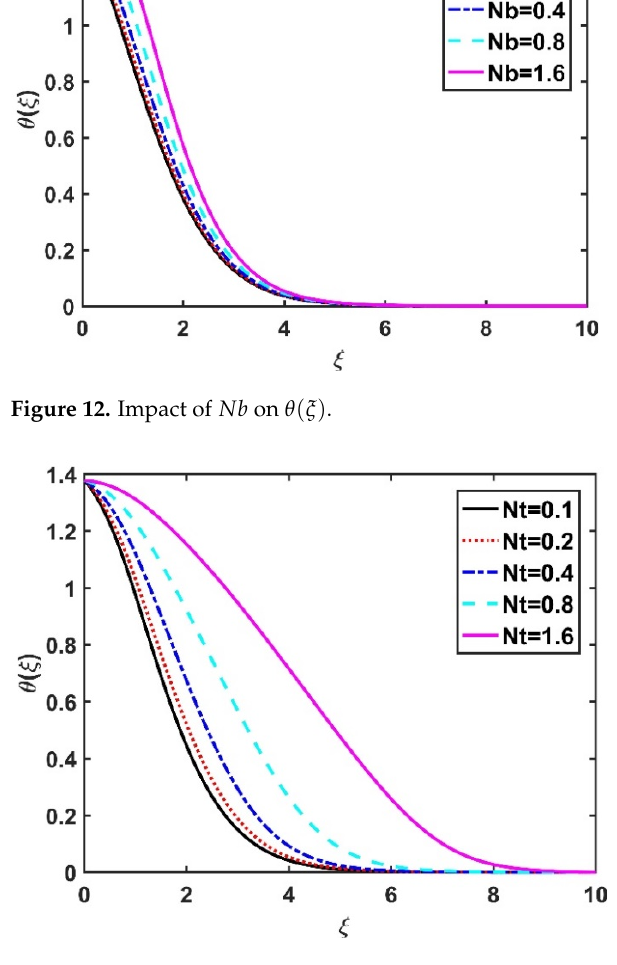
Figure 14. Impact of 𝑅𝑒 on 𝜃(cid:4666)𝜉(cid:4667) . Figure 15. Impact of 𝛼 (cid:2870) on 𝜃(cid:4666)𝜉(cid:4667) . 4.3. Nanoparticle Concentration Profile ( 𝜙(cid:4666)𝜉(cid:4667) ) The effects of the Hall current and magnetic field on 𝜙(cid:4666)𝜉(cid:4667) were contradictory, as shown in Figures 16 and 17. That is, 𝜙(cid:4666)𝜉(cid:4667) rose at the 𝑀 values decreased and the values of 𝑚 increased . The increase in the Brownian number reduced 𝜙(cid:4666)𝜉(cid:4667) , as shown in Figure 18. The greater the strength of Brownian motion, the lower the concentration gradient of